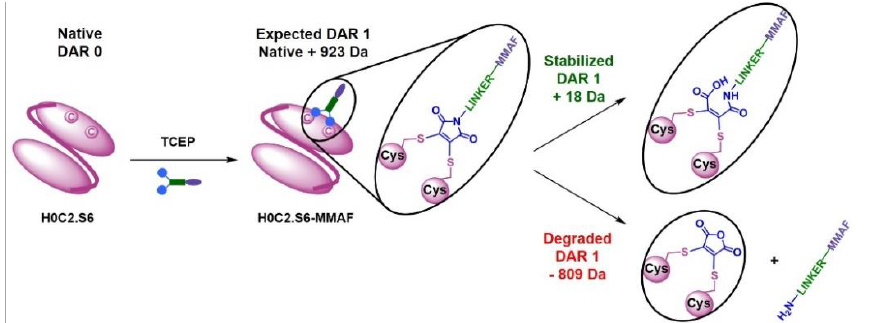
Figure 4. Explanation of analysis of the conjugated fragments H0C2.S6-MMAF. Black species: expected mass increment (+923 Da for DAR 1). Green species: resulted from the stabilization of maleimide(s) into maleic amide(s) by hydrolysis (+18 Da mass increment from a DAR 1). Red species: resulted from the deconjugation (loss) of an aminocaproic-MMAF on a DAR 1 and transformation of maleimide into maleic anhydride (−809 Da loss of mass from DAR 1, also corresponding to a +114 Da mass increment from a native DAR 0).